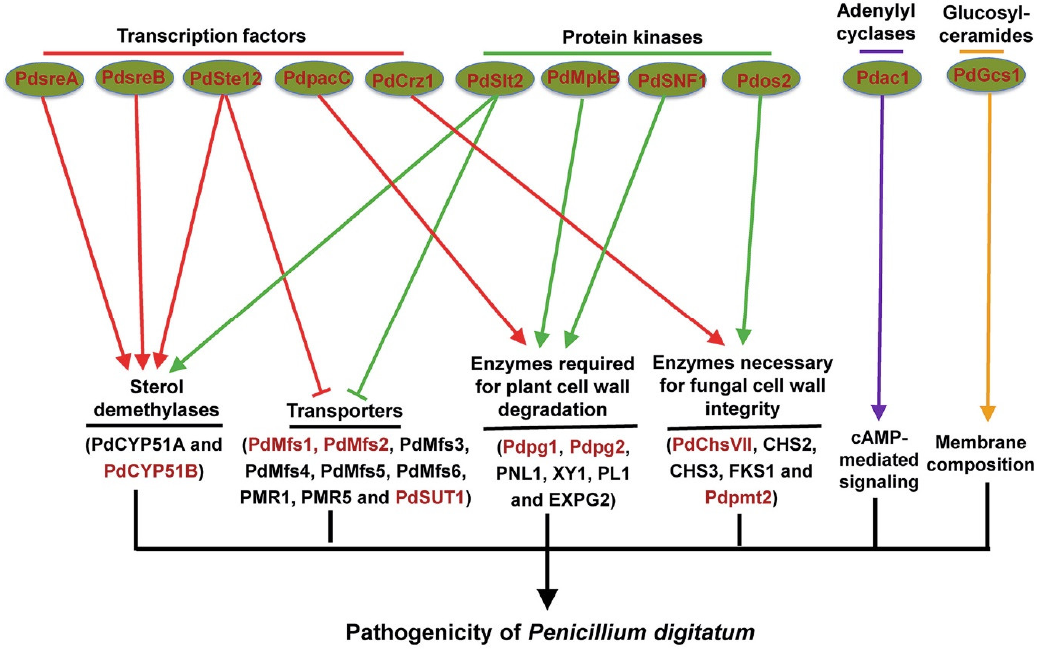
Figure 1. Overview of identified genes (red-colored) involved in the pathogenicity of Penicillium digitatum .